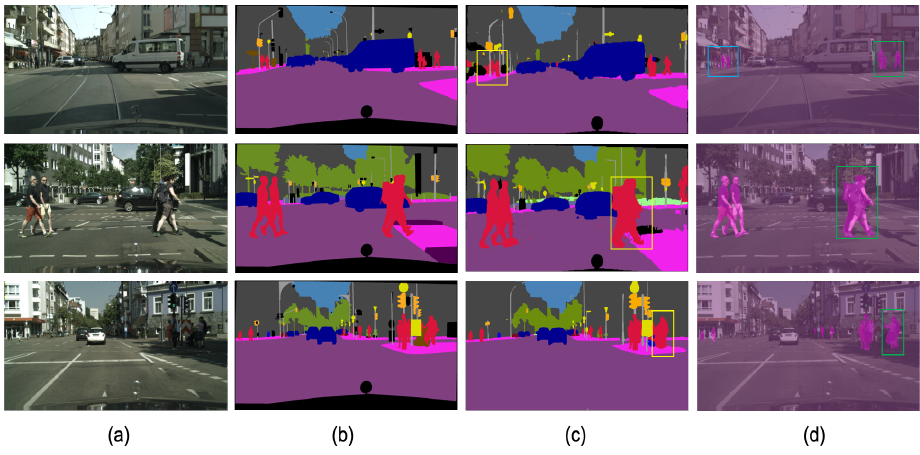
Figure 4. Visual results in the Cityscapes Val set [12] in which we have a comparison with the predictions made by the ERFNet